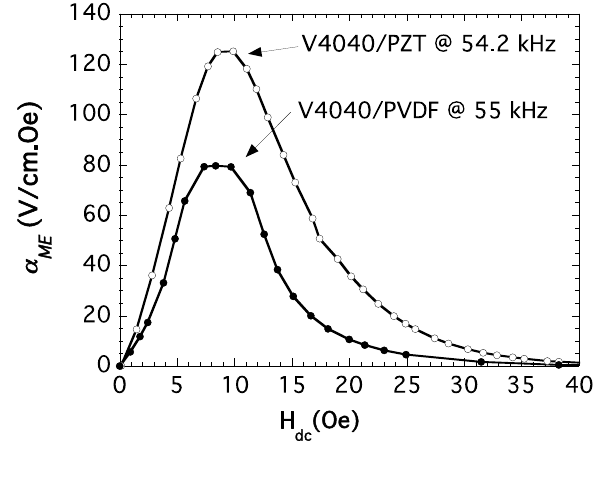
magnetoelectric coupling coefficient for our L-T type laminated Figure 14. Measured α ME composite with VITROVAC 4040 ® as magnetostrictive constituent and ceramic PZT or PVDF polymer as piezoelectric constituent. Sizes of the devices are almost the same, as hinted by their close resonant